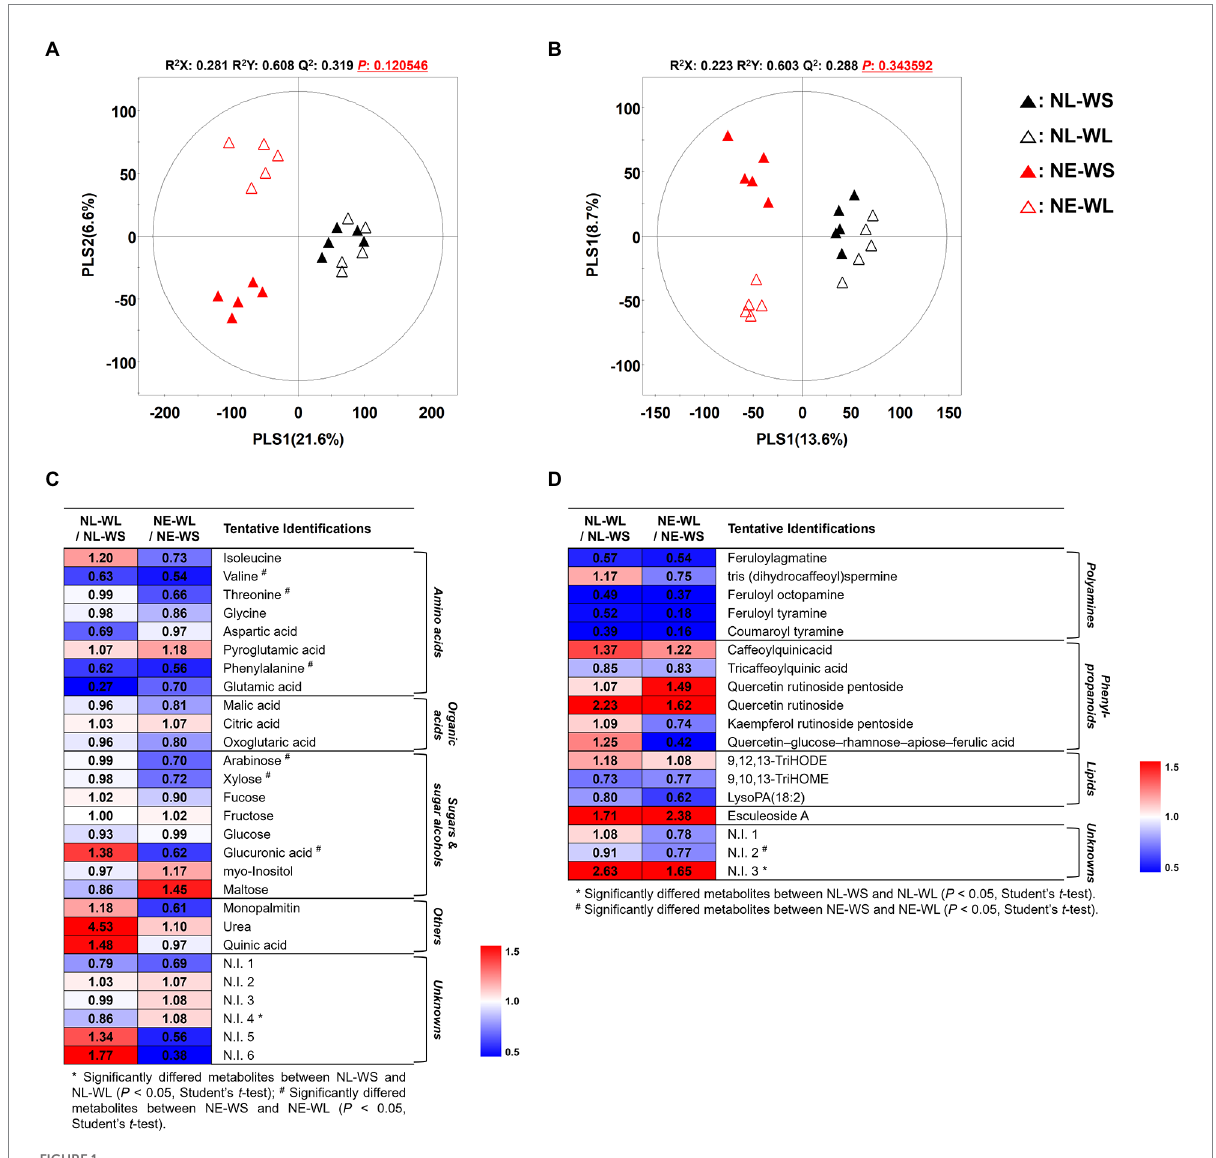
FIGURE 1 PLS-DA score plots from GC-TOF-MS (A) and UHPLC-LTQ-Orbitrap-MS (B) analysis of tomato cultivated under varied nutrient and water conditions. Symbol, NL-WS ( ▲ ); NL-WL ( △ ); NE-WS ( ▲ ); NE-WL ( △ ). Heatmap of the relative changes of metabolites by the water limitation for each soil nutrient condition for the distinguished metabolites derived from GC-TOF-MS (C) and UHPLC-LTQ-Orbitrap-MS (D) datasets (VIP > 0.7). The colored squares (blue to red) indicate fold changes normalized by water sufficient condition for each soil nutrient